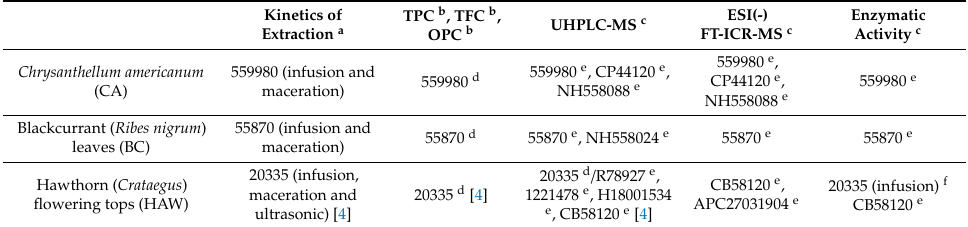
Table 1. List of samples (with lot numbers) studied in this work with the corresponding experimental investigation. For each lot number, three plant extract samples coming from independent extractions were tested. a : on raw and ground 1 mm granulometry; b : on raw, ground 1 mm and ground ‘fine’ granulometry; c : on ground ‘fine’ granulometry; d : all extraction modes were tested; e : optimized infusion protocol only; f : ground 1 mm granulometry. For the granulometry, see Section 2.2. All extraction modes are described in Section 2.3, Section 2.4, Section 2.5, Section 2.6, Section 2.7, Section